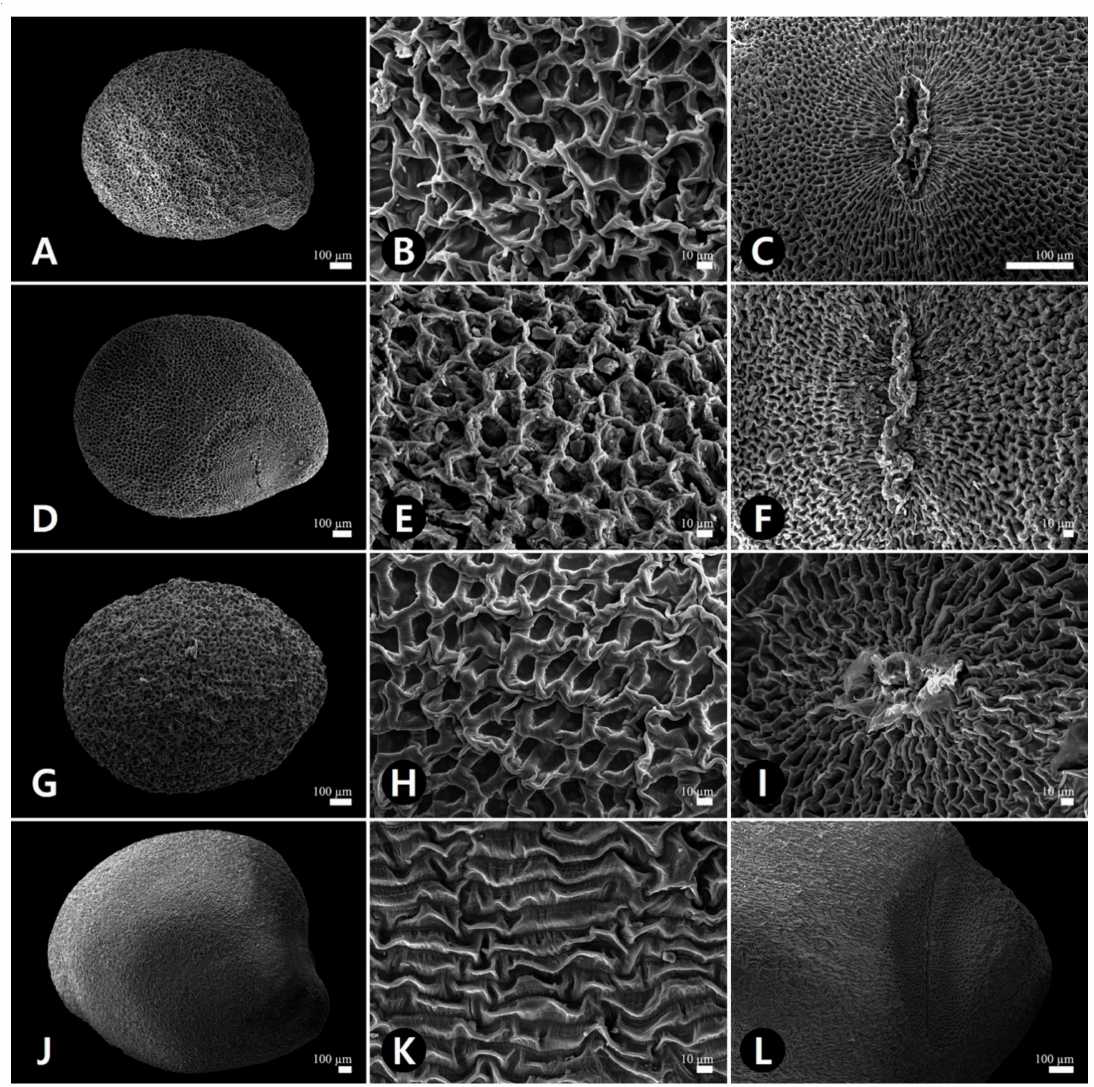
Figure 3. Scanning electron micrographs showing the seed ( A , D , G , J ), detailed testa ornamentation ( B , E , H , K ), and the hilum ( C , F , I , L ). ( A – C ) Cuscuta australis (1). ( D – F ) C. australis (2). ( G – I ) C. chinensis . ( J – L ) C. japonica